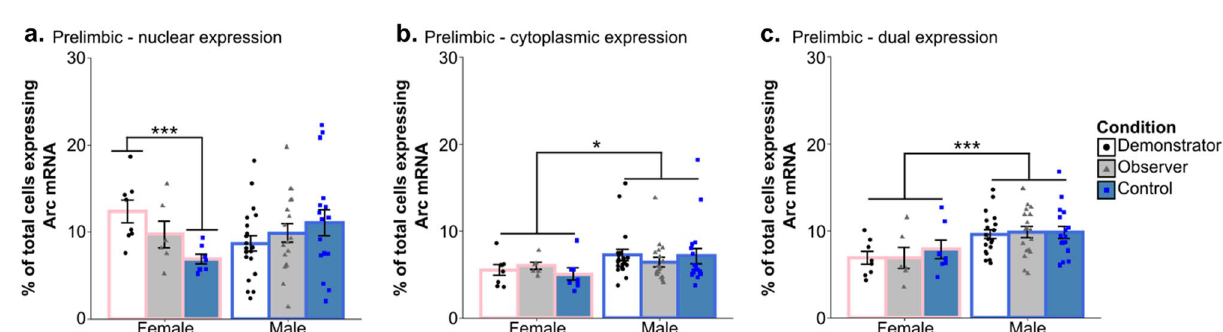
Figure 7. Differences in Arc expression between male and female rats across the prelimbic cortex. Initial ANOVA analysis found a significant sex and condition interaction in ( a ) the nuclear prelimbic counts, with female Demonstrators showing significantly more Arc expression than female Controls. Compared to males, females had lower overall ( b ) cytoplasmic and ( c ) dual Arc expression in the prelimbic cortex. Values are the mean ± SEM. *p < 0.05, ***p <